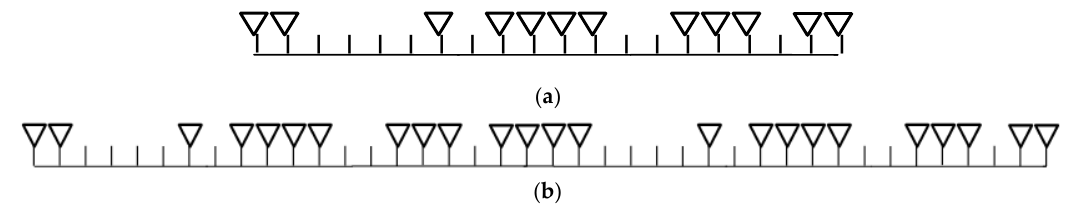
Figure 3. ( a ) The optimized receiver array arrangement; ( b ) Virtual equivalent array of MIMO system.